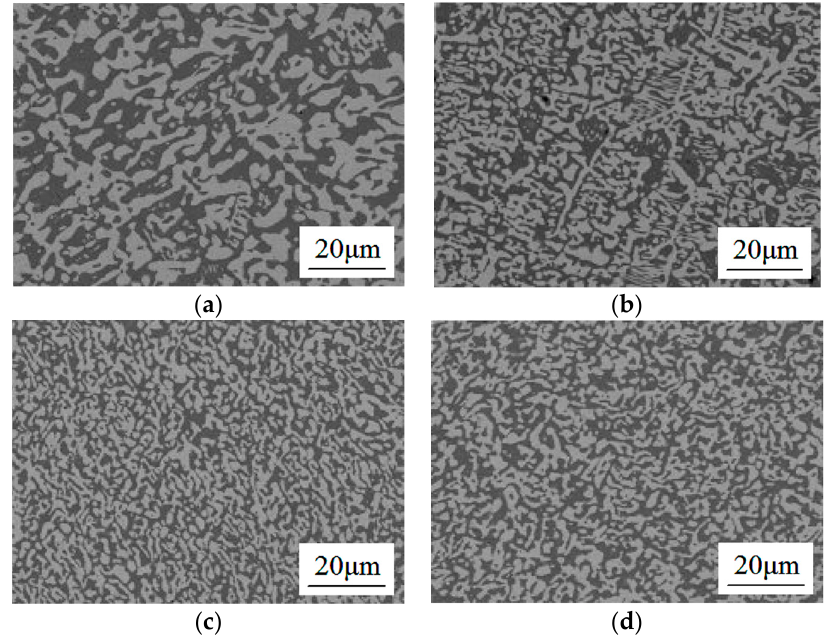
Figure 8. SEM morphology of as-prepared solder: ( a ) Pure SnBi solder; ( b ) SnBi solder-doped 31 nm Ag nanoparticles; ( c ) SnBi solder-doped 76 nm Ag nanoparticles; ( d ) SnBi solder-doped 133 nm Ag nanoparticles [57].